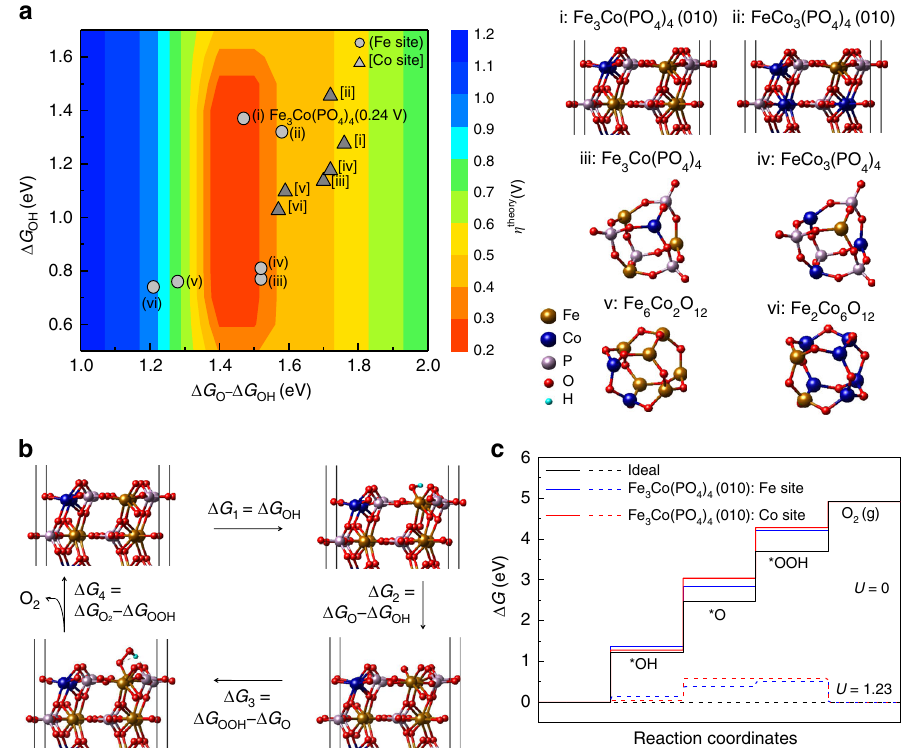
Fig. 1 DFT-predicted structures, overpotentials, and free-energy pro fi les. a 2D color-coded map of theoretical overpotential η theory as function of free energies Δ G O − Δ G OH and Δ G OH for various compositions (i: Fe 3 Co(PO 4 ) 4 (010), ii: FeCo 3 (PO 4 ) 4 (010), iii: Fe 3 Co(PO 4 ) 4 cluster, iv: FeCo 3 (PO 4 ) 4 cluster, v: Fe 6 Co 2 O 12 cluster, vi: Fe 2 Co 6 O 12 cluster) at Fe (gray circle) and Co (dark gray triangle) active sites. b Optimized geometries of the *O, *OH, and *OOH intermediates on the Fe sites of Fe 3 Co(PO 4 ) 4 (010) (Supplementary Table 1). c Free-energy pro fi les of OER at zero and equilibrium (1.23 V) potentials for Fe and Co sites of Fe 3 Co(PO 4 ) 4 (010). OER typically undergoes a four-electron step process in alkali media. In an ideal case, the free-energy changes by 1.23 V at each step (black line). The conversion of *OH to *O is the rate-determining step on both Fe site ( Δ G 1 = 0.24V) and Co site ( Δ G 2 = 0.53 V). Source data for a and c are provided as a Source Data fi